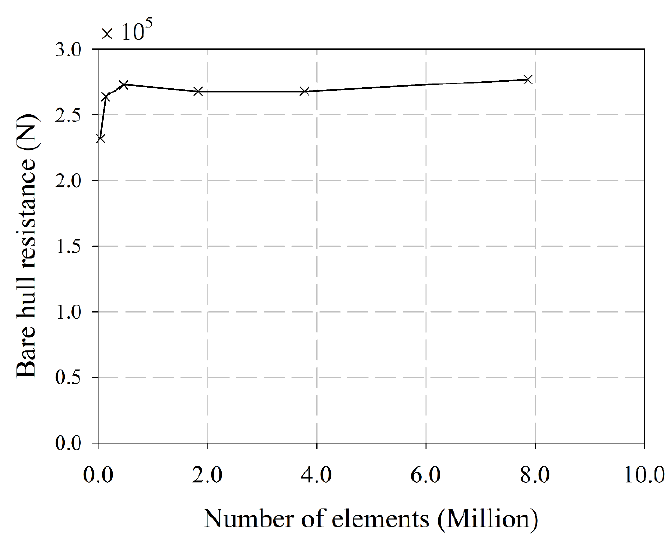
Figure 4. Mesh dependence analysis for bare hull resistance computations. Source: Own elabora- tion.